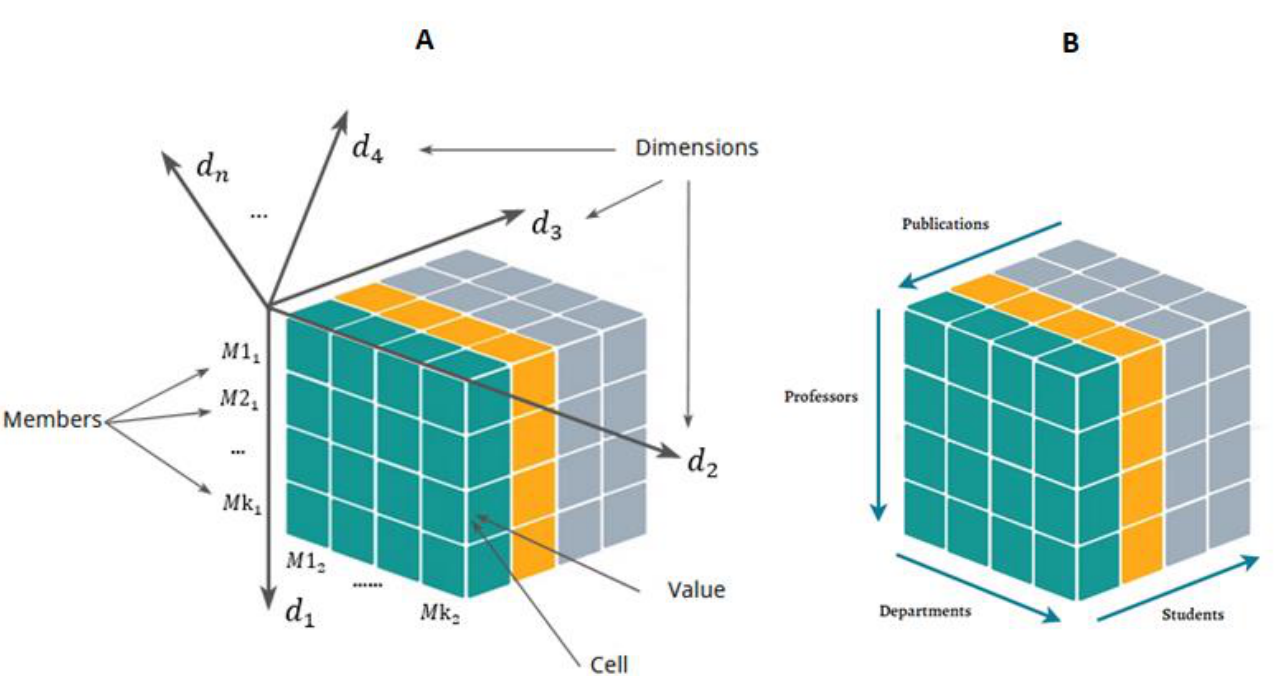
Figure 2. The hypercube sequence (A) and the 4-D hypercube (B).